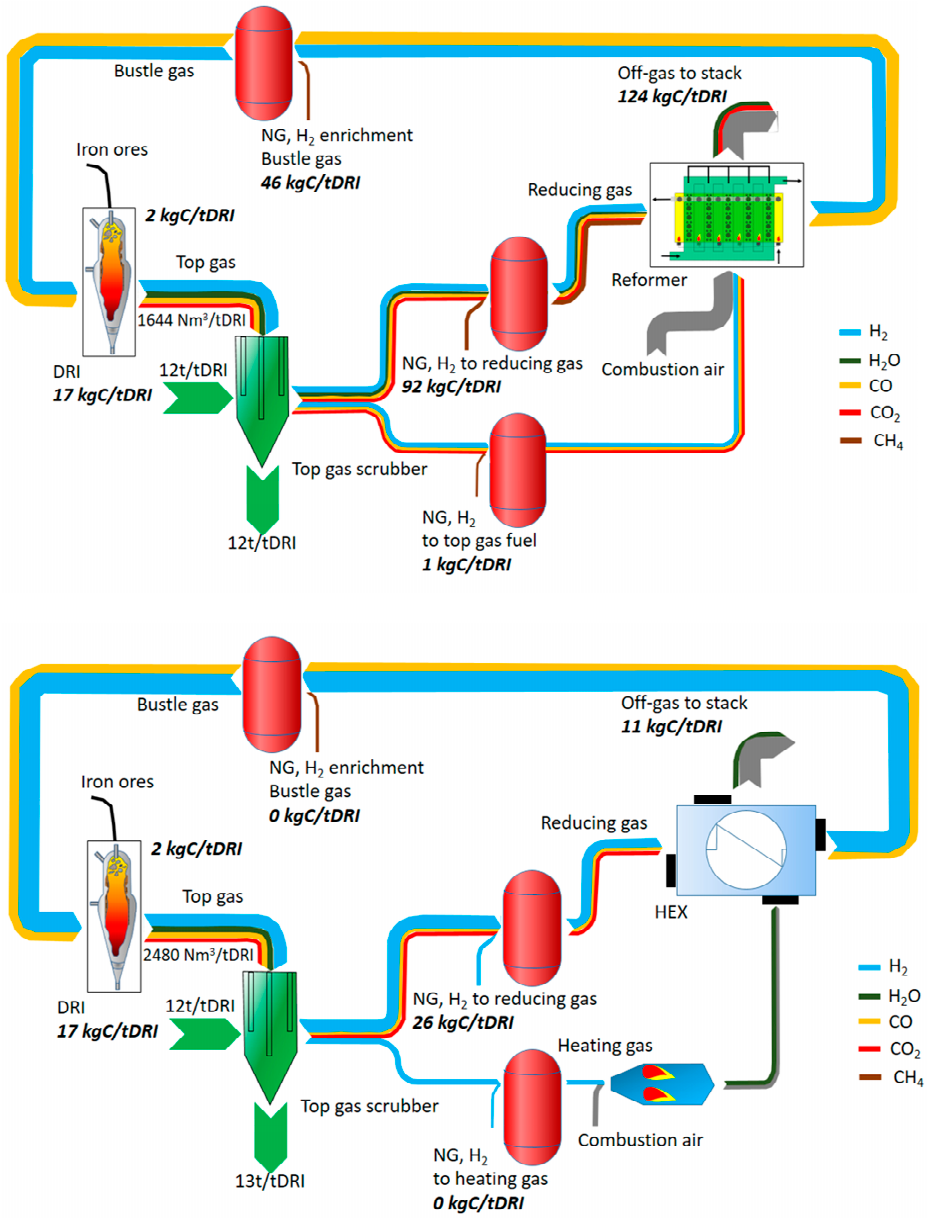
Figure 16. Schematic of the NG-and H2-based Midrex plants.